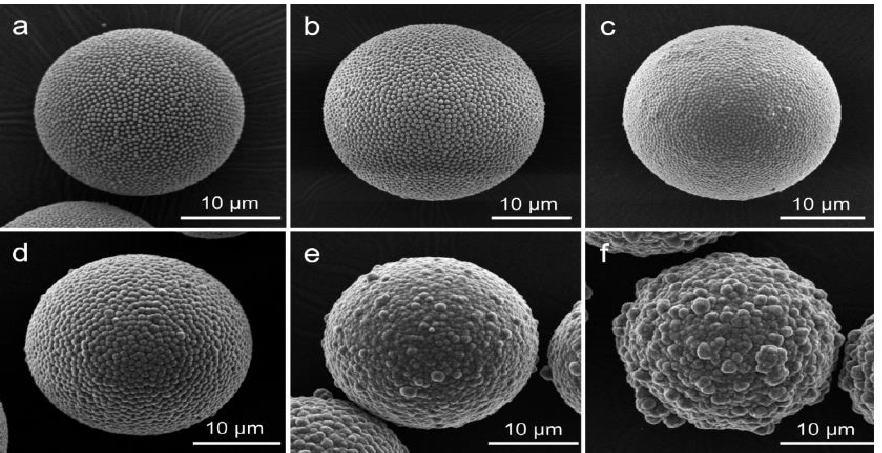
Figure 15. SEM images of the coated MSiNPS at different TEOS volume. ( a ) No TEOS, only MSiNPS, ( b ) 0.04 mol/L, ( c ) 0.08 mol/L, ( d ) 0.16 mol/L, ( e ) 0.32 mol/L, ( f ) 0.48 mol/L [107].